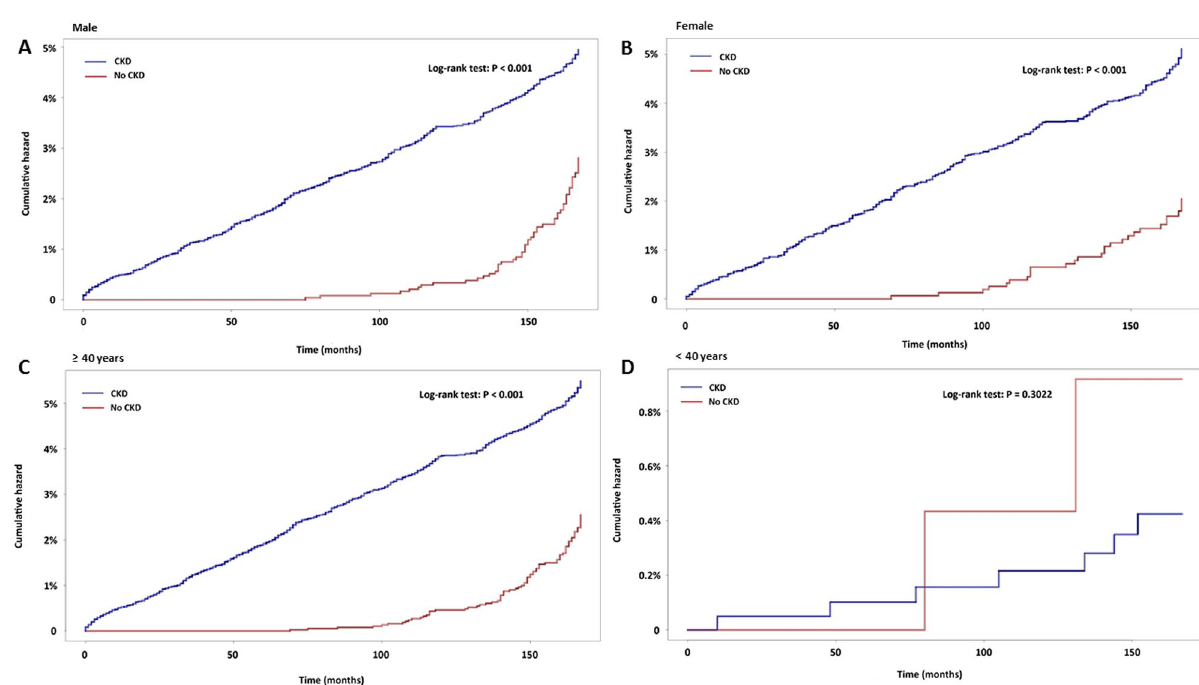
Figure 3. Cumulative hazards of open-angle glaucoma in CKD patients according to sex ( A,B ) and age group (≥ 40 or < 40 years, C,D